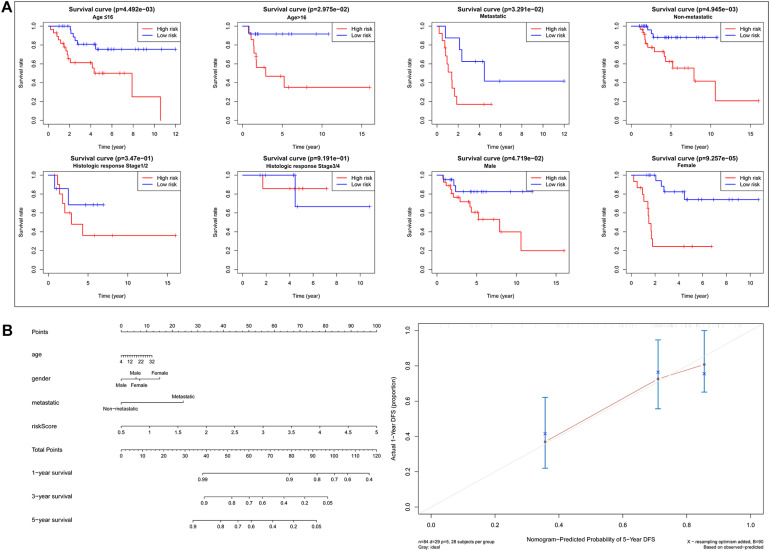
Analysis of prognosis signature with other clinical characteristics. (A) Stratification analysis to investigate the prognostic value of the six metabolic genes signature (age, metastatis, gender, histologic response). (B) Nomogram for predicting 1, 3, and 5-year survival rates of OS patients based on the six metabolic genes signature risk score and other clinical characteristics, such as age, gender, and metastatis. Calibration curve of the nomogram for 5-year survival rates.